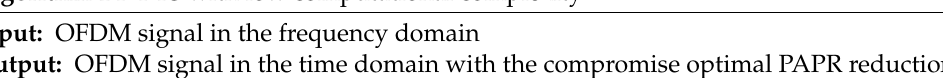
Algorithm 1 F-PTS with low computational